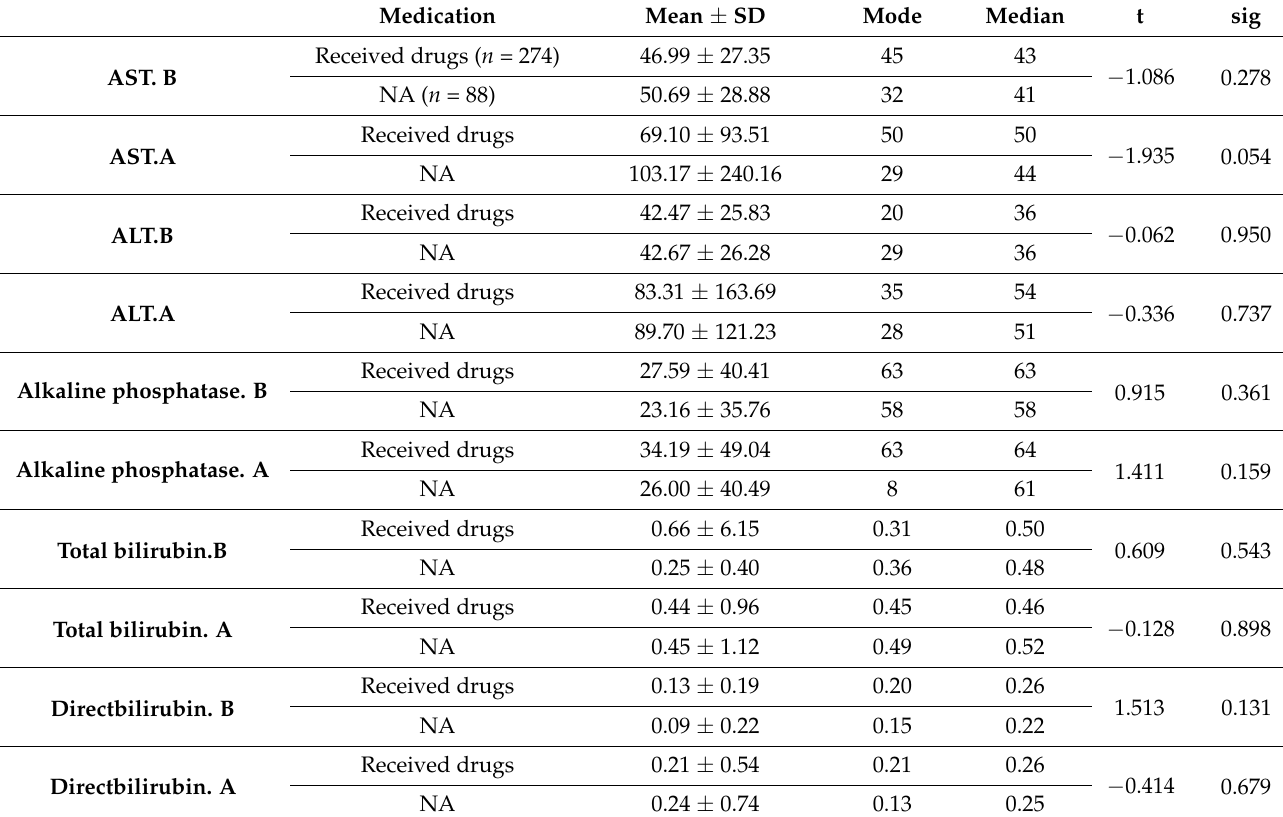
Table 2. The effect of using another medication on liver